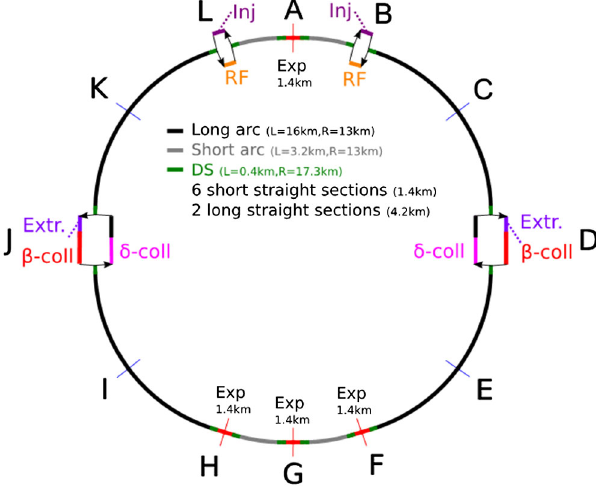
FIG. 1. Layout of the FCC collider. Courtesy D. Schulte.